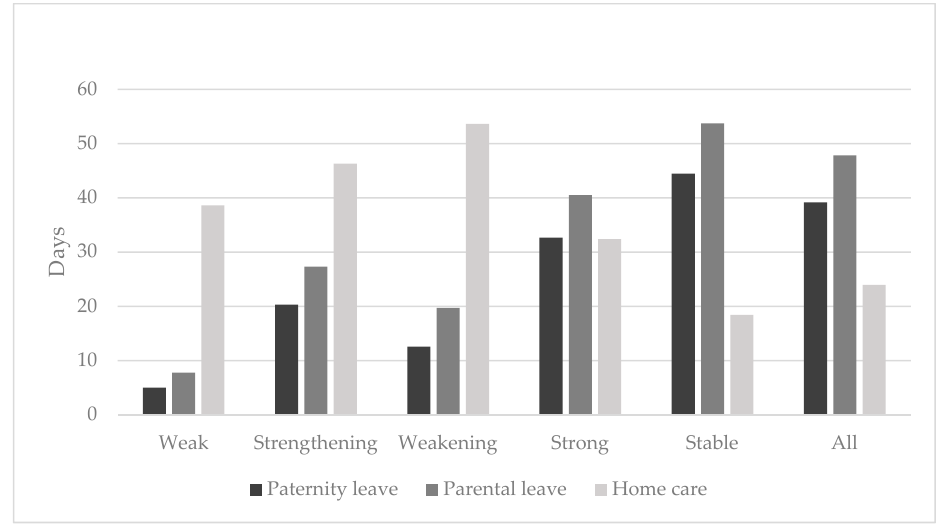
Figure 4. Father’s family leave days by trajectory group and type of family leave (total of days 2005–2016).